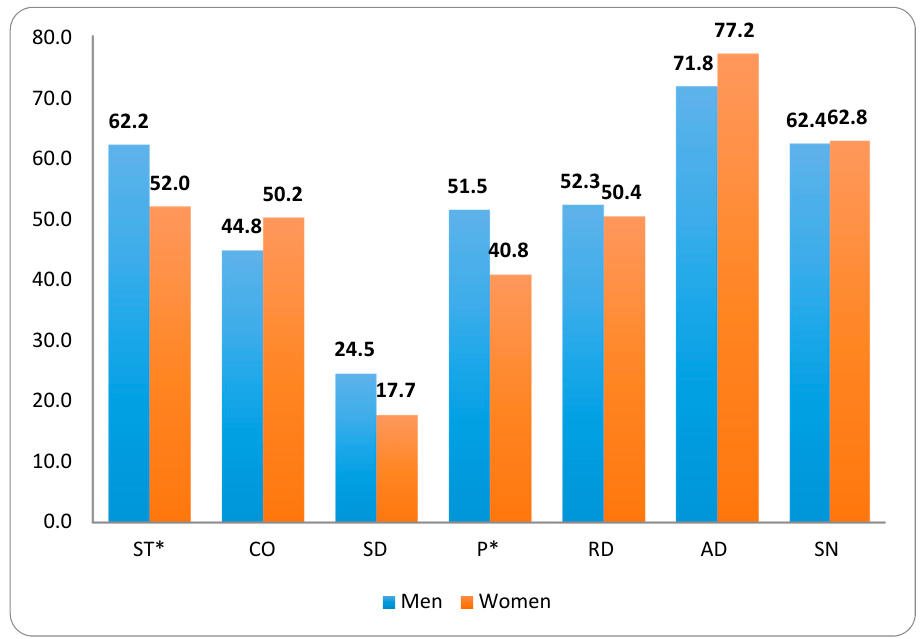
Figure 1. Cloninger’s (TCI-R) personality scores as a function of gender (P* and ST* statistically